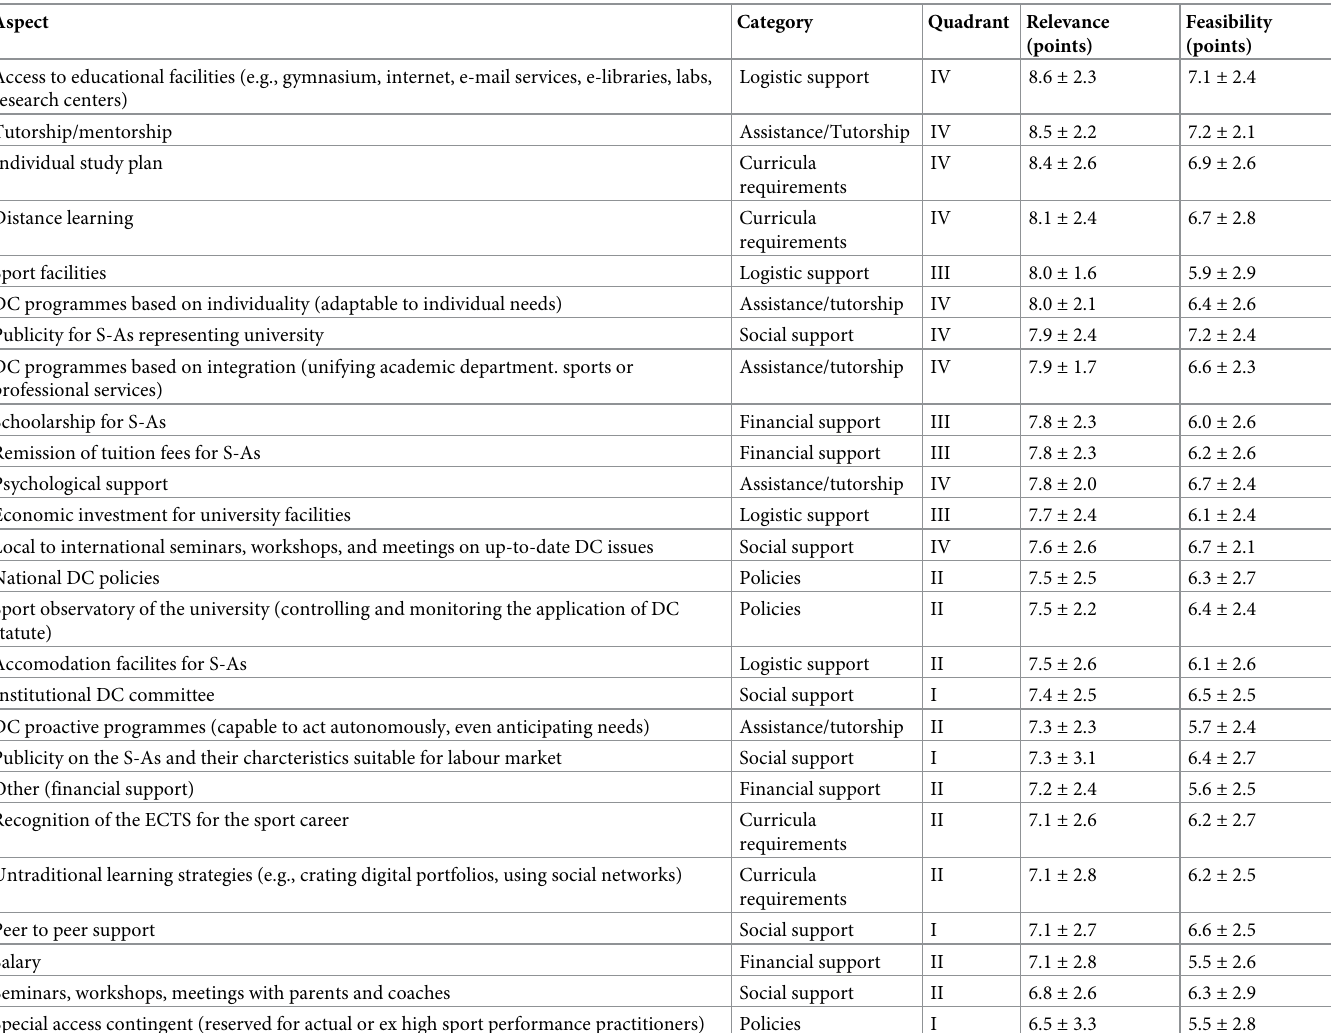
Table 3. Aspects considered relevant for dual career in descending